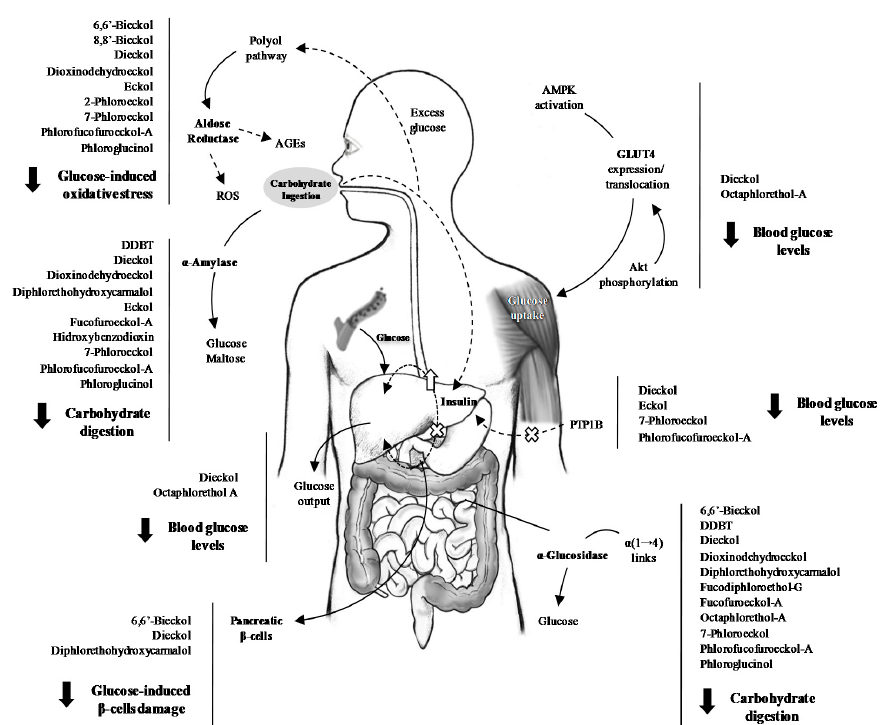
Figure 3. Schematic representation of the main diabetes-related targets of phlorotannins (AGEs: advanced glycation end-products; Akt: protein kinase B; AMPK: AMP-activated protein kinase; DDBT: 2-(4-(3,5-dihydroxyphenoxy)-3,5-dihydroxyphenoxy) benzene-1,3,5-triol; G6P: glucose-6-phosphatase; GLUT4: glucose transporter 4; PEPCK: phosphoenolpyruvatecarboxykinase; PTP1B: protein tyrosine phosphatase 1B; ROS: reactive oxygen species).